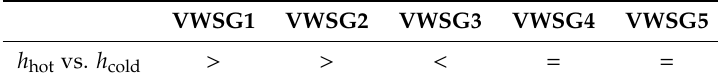
Table 4. Hot / cold heat transfer coe ffi cient